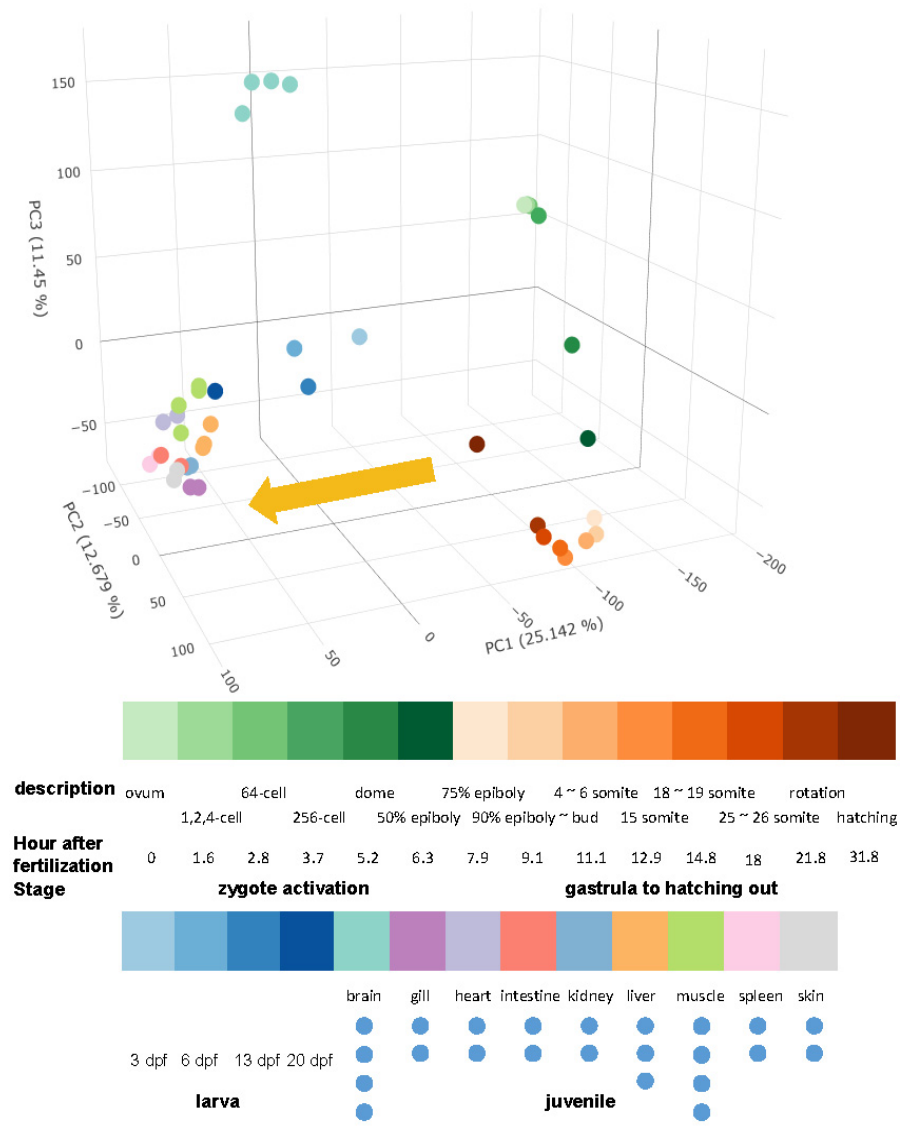
Figure 2. Principal compartment analysis (PCA) performed on all samples. (Top) Three-dimensional PCA diagram, in which the embryo development direction is indicated by the yellow arrow. (Bottom) The color panel and the development information for all